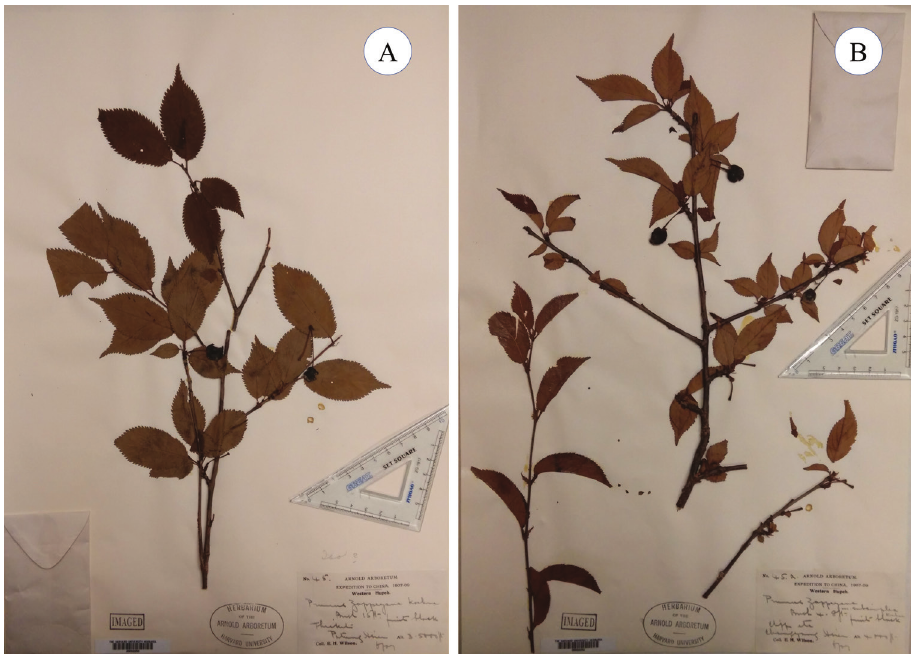
Figure 1. Original specimens of Prunus zappeyana and P . zappeyana var. subsimplex A lectotype of P . zappeyana , Wilson 45 (A 00032250) B one of the original specimens of P . zappeyana var. subsimplex , Wilson 45a (A